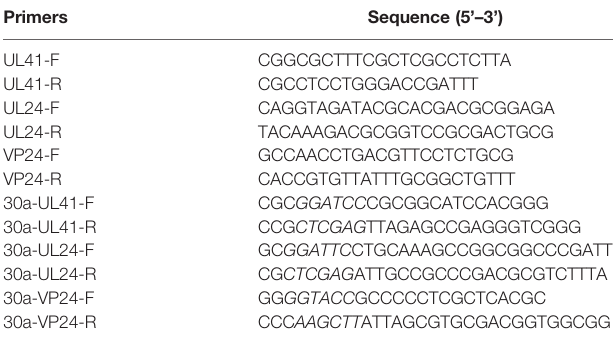
TABLE 1 | Cloning and expression primers used in this